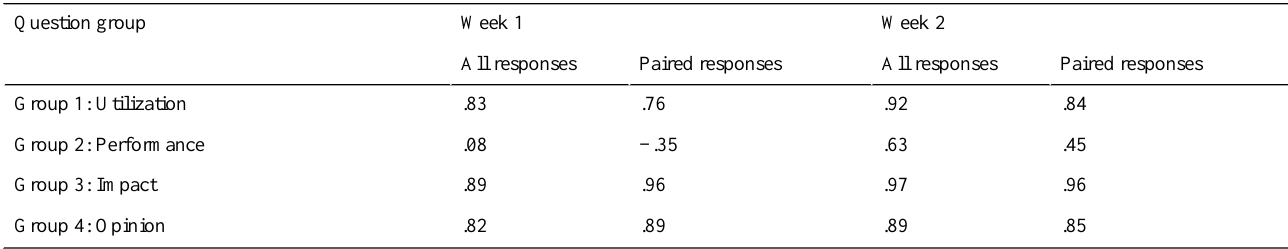
Table 6. Cronbach alpha for grouped survey questions.